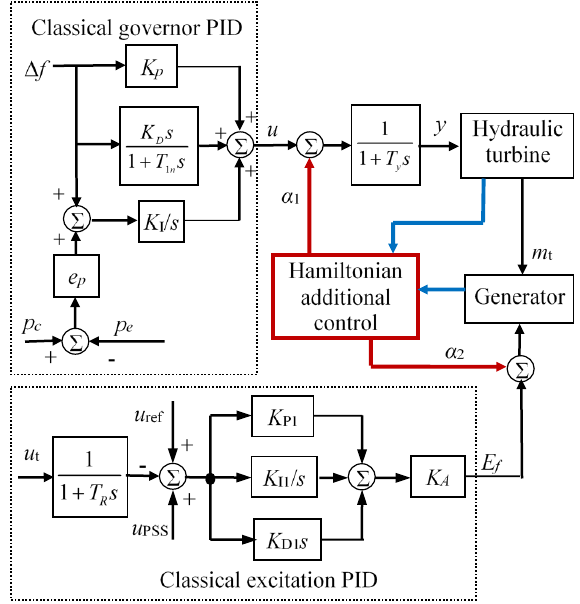
Figure 1. Control structure.